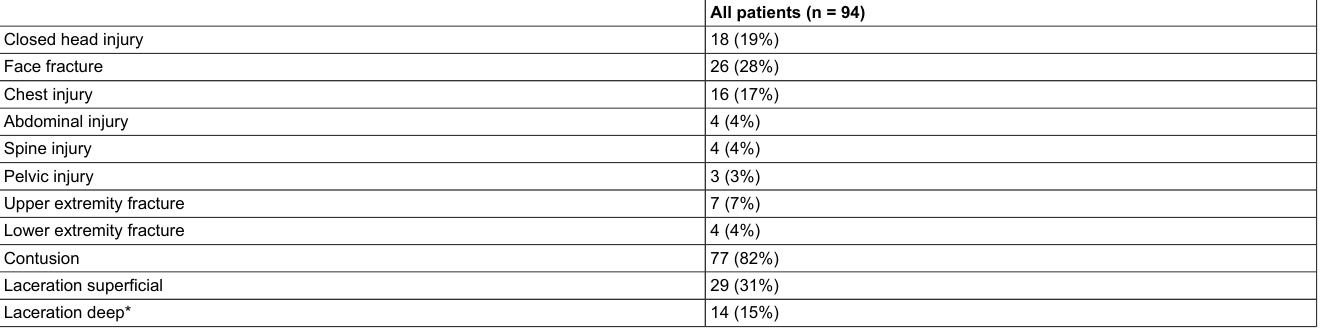
Table 2: Injury distribution in patients admitted after cattle-related trauma. Percentages exceed 100% due to multiple injuries per patient. Values are numbers (percentages).